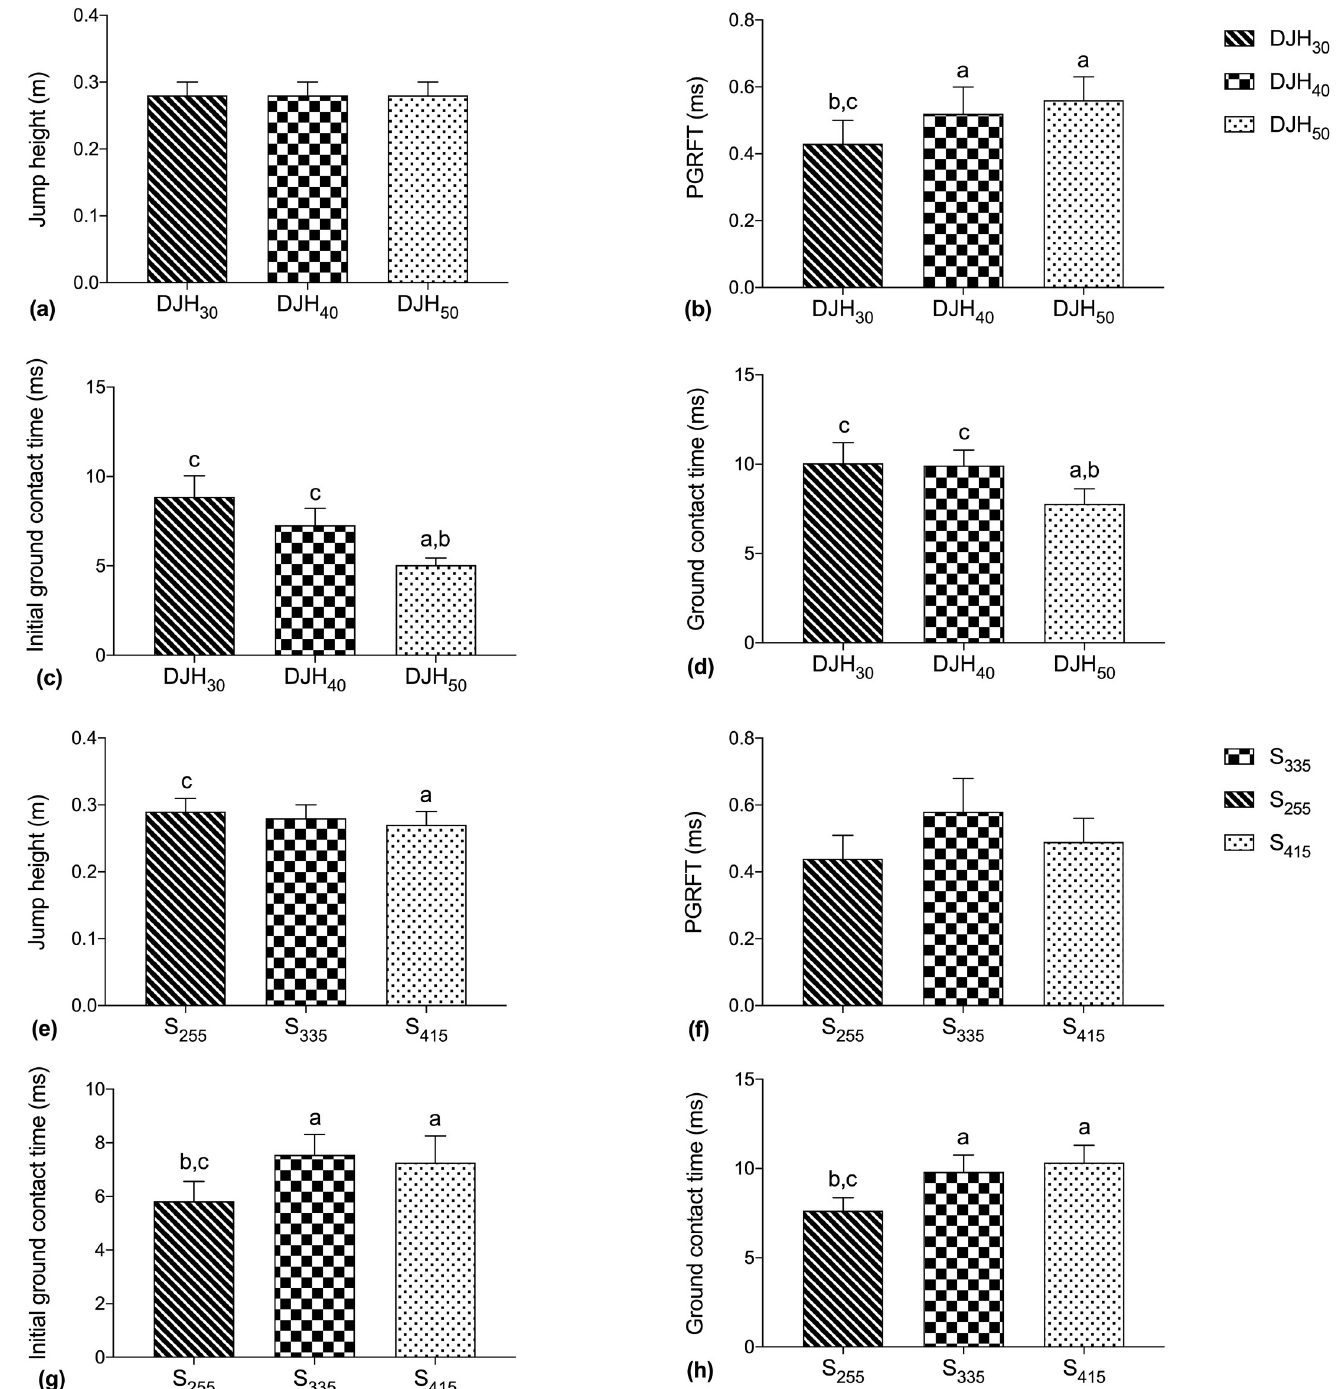
Fig 2. The side-to-side asymmetries in leg kinetics: mean (SD) main effects of drop height (a)~(d) and shoe weight (e)~(h). For the main effects of drop height, a: indicates a significant difference from DJH 30 ; b: indicates a significant difference from DJH 40 , c: indicates a significant difference from DJH 50 ; for the main effects of shoe weight, a: indicates a significant difference from S 225 ; b: indicates a significant difference from S 335 , and c: indicates a significant difference from S 415 .